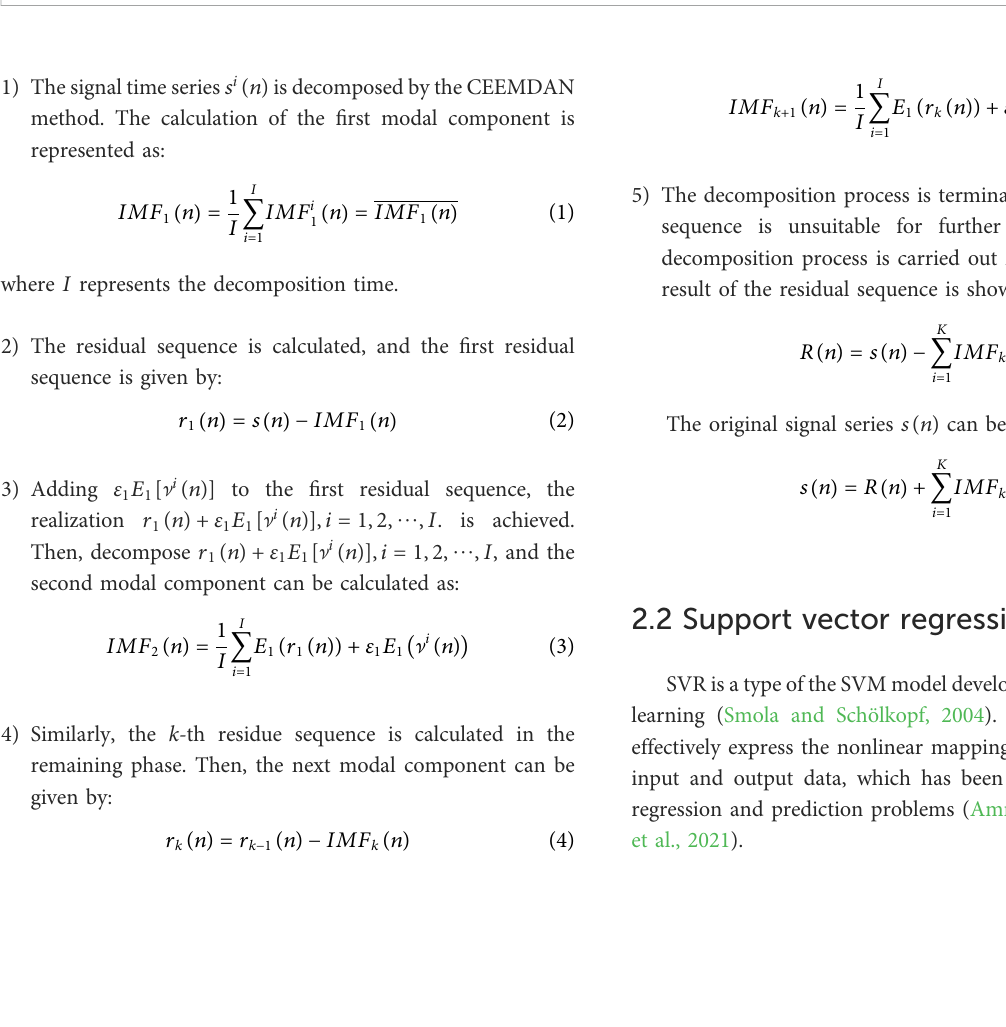
FIGURE 4 Decomposition results of B5 capacity by EEMD and CEEMDAN. (A) EMD, (B)